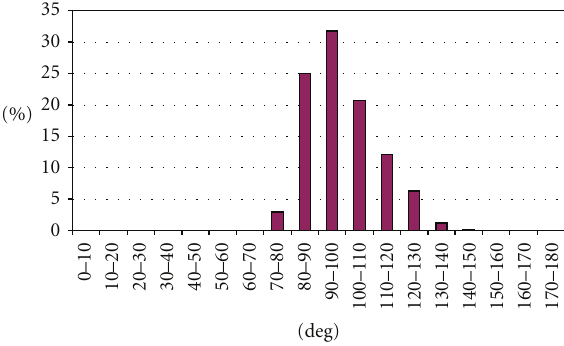
Figure 6: Histogram of the largest angle of